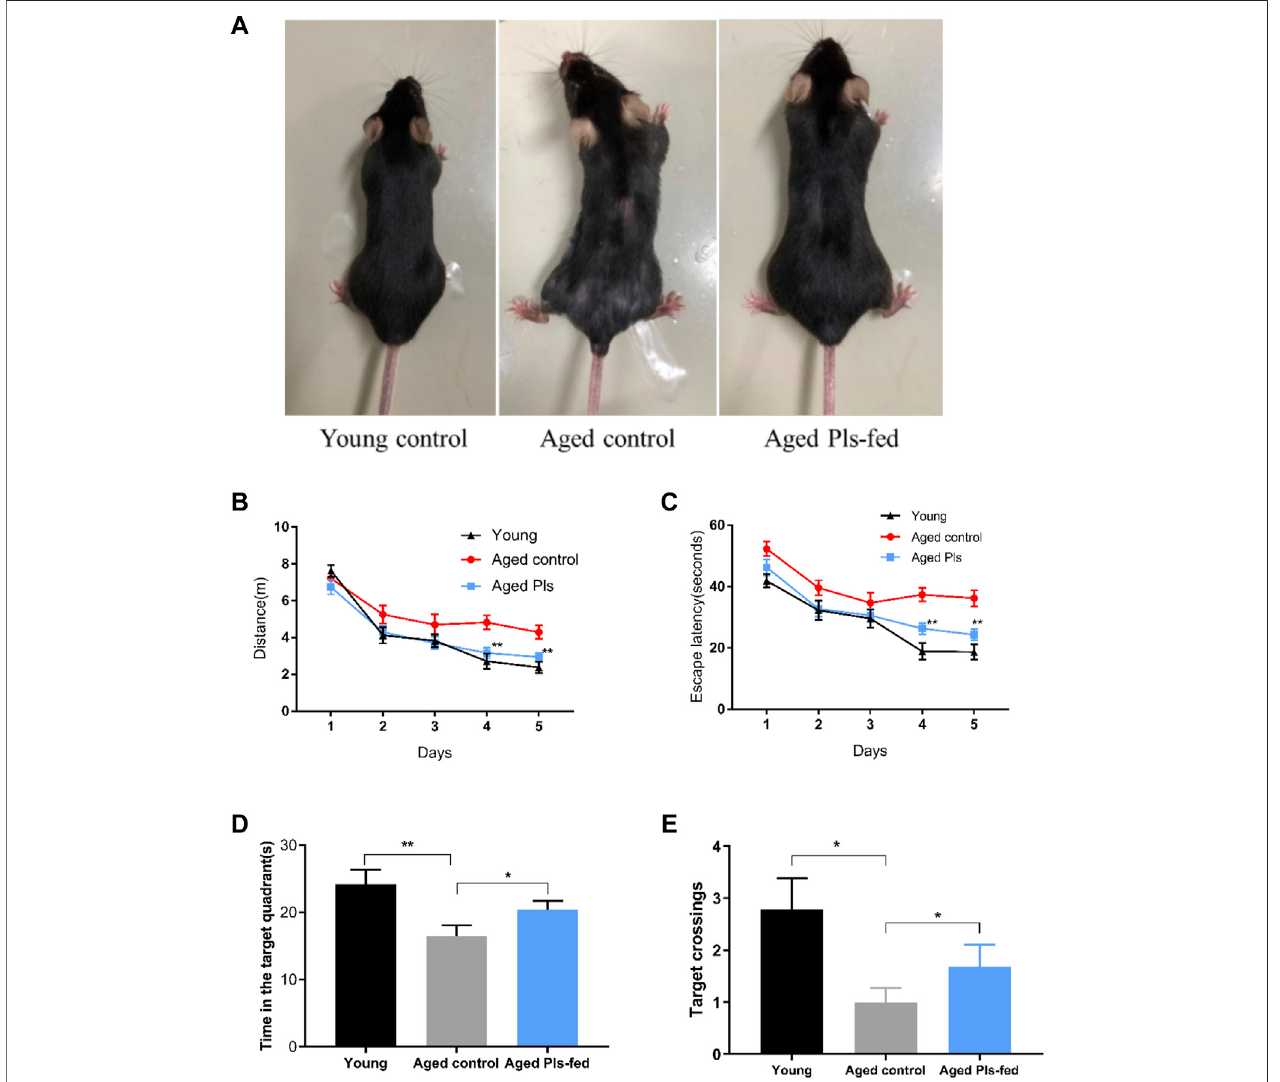
FIGURE 2 | Effects of 2-months Pls supplementation on the appearance and cognitive behaviors of aged mice. (A) Representative photos of young mice (3 months),agedPls-fedmice(18 months),agedcontrolmice(18 months). (B – E) SpatialreferencelearningandmemoryweredeterminedandcharacterizedinaMorris water maze study. Mice were trained in Morris water maze for consecutive 5 days, four trials per day. The probe trials were tested on the 6th day. The distance traveled (B) and time spent (C) to reach the escape platform are demonstrated respectively. A bar graph summarizes the time spent within the target quadrant (D) and platformcrossingnumbers (E) .Dataarepresentedasmean±SEM,with13 – 16miceineachgroup(Young, n =14;Agedcontrol, n =13;AgedPls-fed, n =16).Asterisks indicate statistical signi fi cances compared to Aged control using one-way ANOVA; Statistical signi fi cance (* p < 0.05; ** p < 0.01).